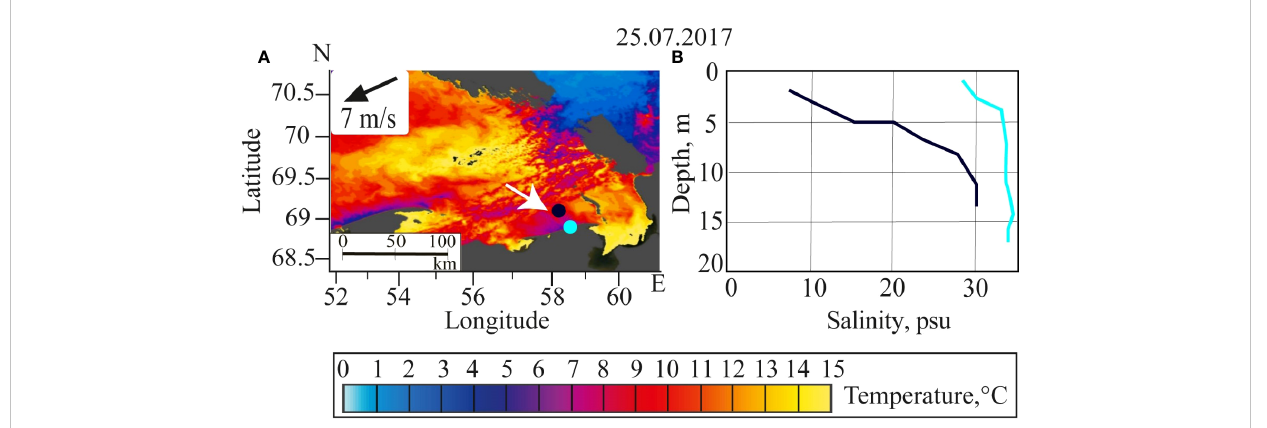
FIGURE 12 Satellite-derived Sea surface temperature in the Pechora Sea on 25 July 2017 acquired by MODIS Terra (A) and vertical salinity measurements performed on 26 July 2017 within (cyan color) and outside (black color) the upwelling area (B) . Area of upwelling events indicated by white arrow in panel (A) . Colored circles indicate locations of the in-situ measurements. Dark grey color indicates land, white color indicates cloud coverage of the study area. Wind direction and velocity averaged during two days preceding the satellite image are shown in the inset.